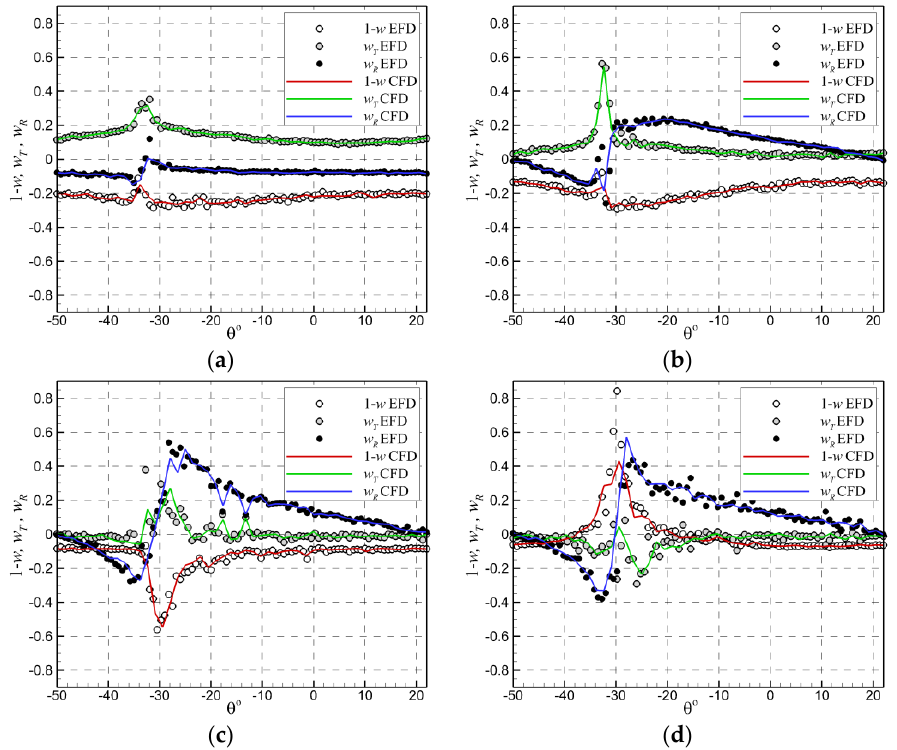
Figure 12. Comparisons between the wake components measured [44] and computed at x / D =0.1. ( a ): r / R =0.7; ( b ): r / R =0.9; ( c ): r / R =0.97; ( d ): r / R =1.0. ( a ): r / R = 0.7; ( b ): r / R = 0.9; ( c ): r / R = 0.97; ( d ): r / R =